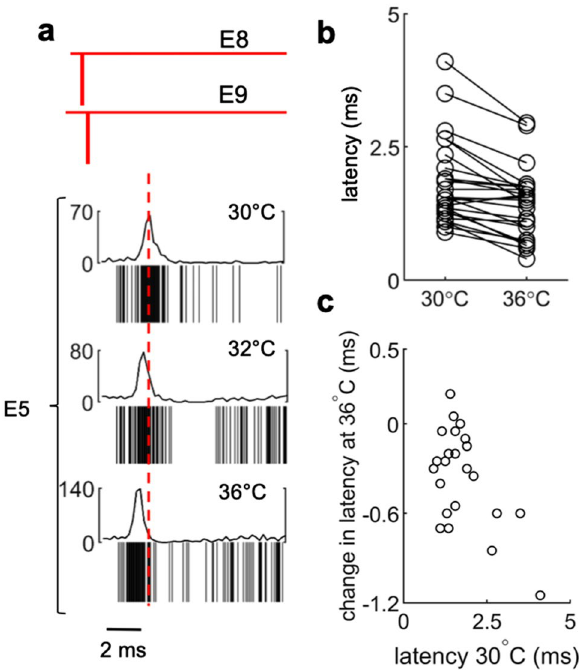
Figure 5. Temperature increase reduces coupling latency. ( a ) Spikes from a propagating neuron detected at E8 and E9 coupled to a postsynaptic unit in E5. At 30 °C the average latency between propagation signal spikes and the CCG peak in E5 was 2.75 ± 0.47 ms. Temperature in the same culture was increased to 32 °C and 36 °C sequentially, the average latency of the CCG peaks were 2.15 ± 1.09 ms and 1.80 ± 0.91 ms, respectively (1 MEA was used over 3 recording sessions for ( a ). ( b ) The distribution of average latency of presynaptic propagation signals coupled to postsynaptic units at 30 °C is significantly different than the average latency of the same couplings at 36 °C (1.76 ± 0.8 ms at 30 °C, 1.41 ± 0.7 ms at 36 °C; n = 23; P < 0.0001, paired t-test, two-sided). ( c ) Average latency of couplings at 30 °C versus the change in average latency of the same couplings at 36 °C. (7 MEAs were used with 2 recording sessions per MEA, 14 total sessions, for ( b ) and ( c